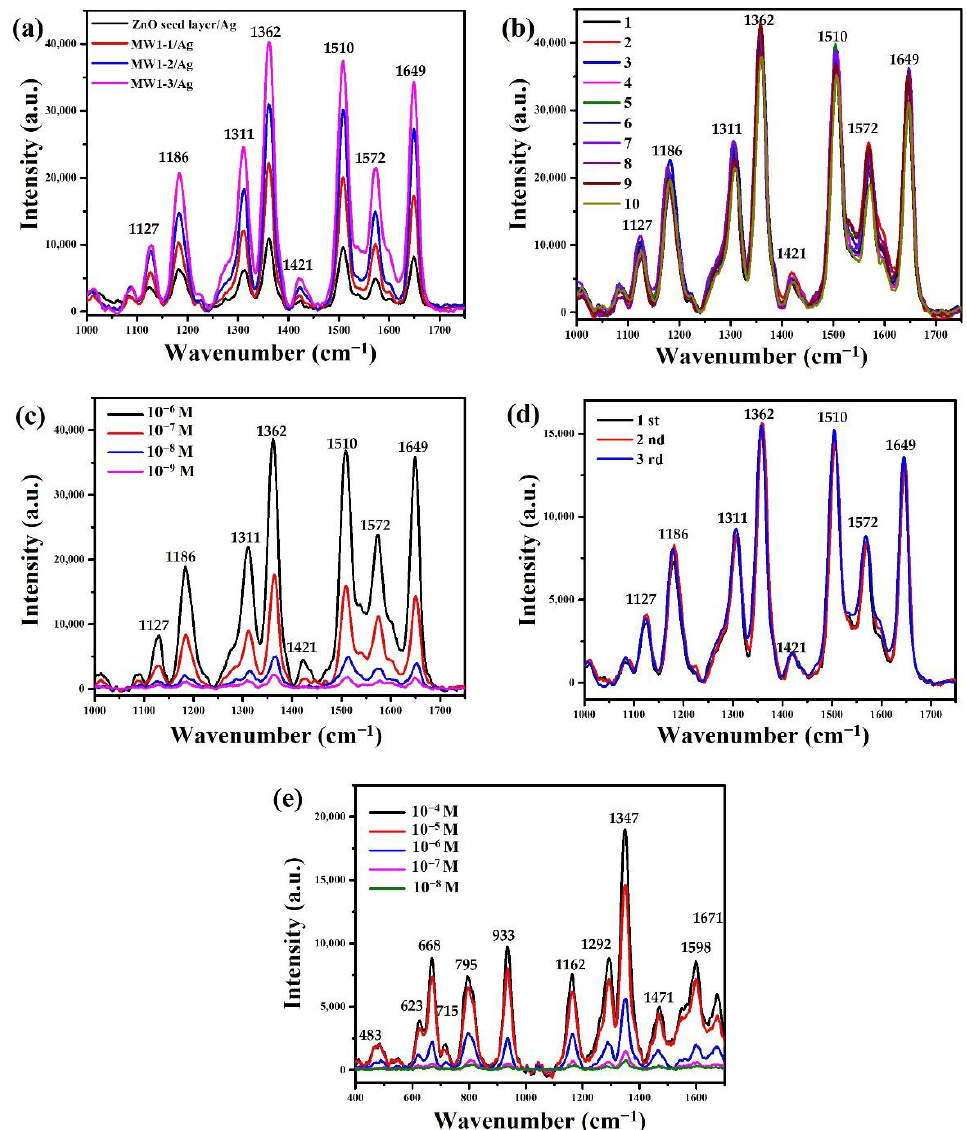
Figure 8. ( a ) SERS spectra of R6G (10 −6 M) on ZnO/Ag nanoneedle arrays at the optimized temperature programming step. ( b ) The uniformity of SERS spectra of R6G (10 −6 M) on ZnO/Ag nanoneedle arrays (MW1-3). ( c ) SERS spectra of R6G at different concentrations (10 −6 M – 10 −9 M) were obtained from ZnO/Ag nanoneedle arrays (MW1-3). ( d ) The reusability of SERS spectra of R6G (10 −7 M) on ZnO/Ag nanoneedle arrays (MW1-3). ( e ) SERS spectra of amoxicillin at different concentrations (10 −4 M – 10 −8 M) were obtained from ZnO/Ag nanoneedle arrays (MW1-3).